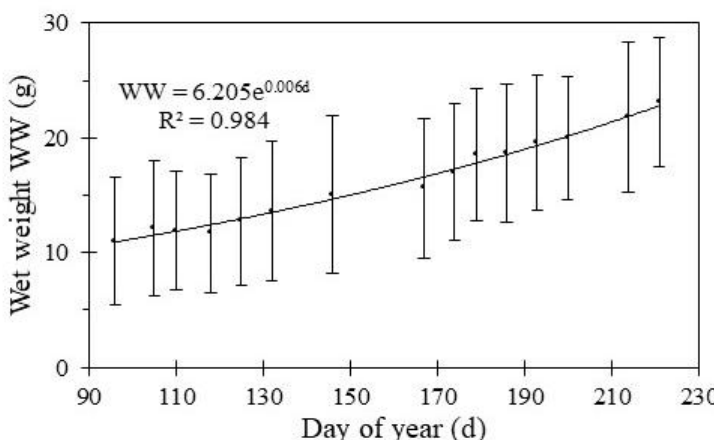
Figure 1. Halichondria panicea. Development of mean ± SD wet weight as a function day of year. Exponential regression curve (LM, t 0.015, 13 = 9.3 × 10 −5 , p = 6.8 × 10 −13 ) shows a weight-specific growth rate of 0.6% d −1 . Data from [6].